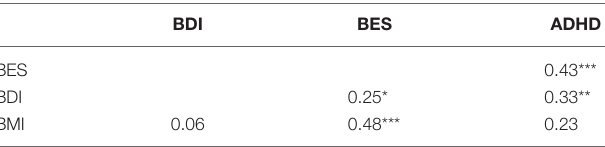
TABLE 7 | Correlations between binge eating, body mass index, depression, and ADHD